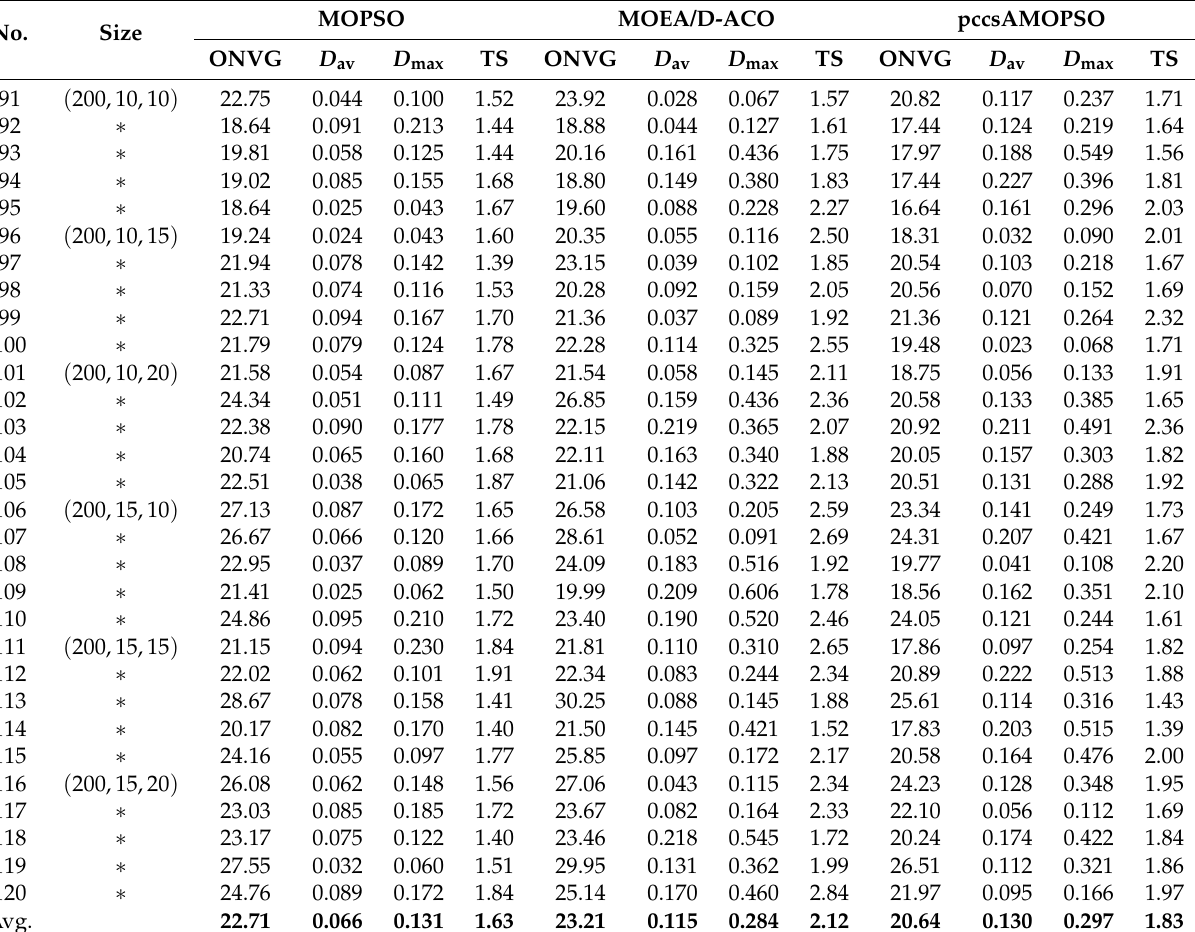
Table 7. Comparison of MOPSO with MOEA/D-ACO and pccsAMOPSO on the test instances with 200